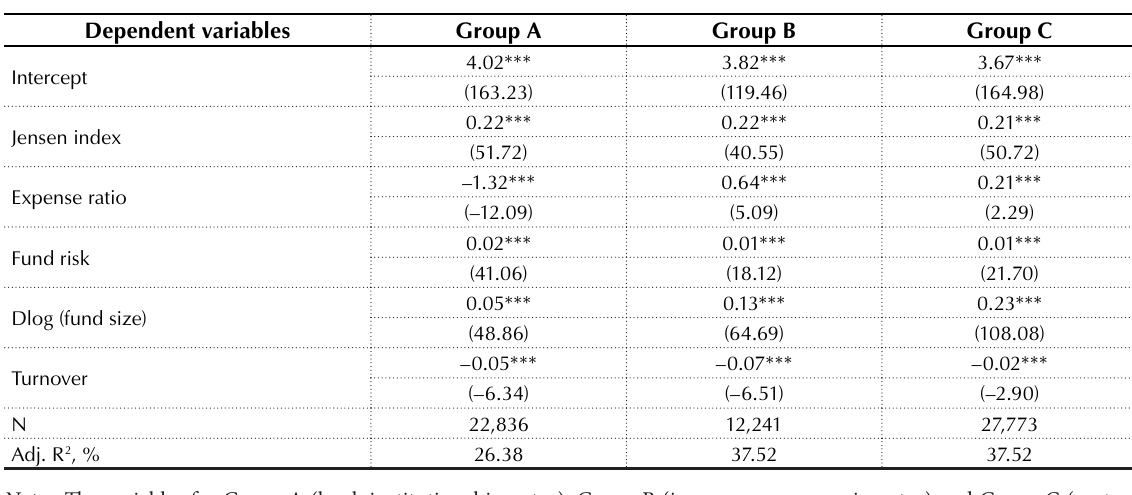
Table 4. Groups regression model of fund